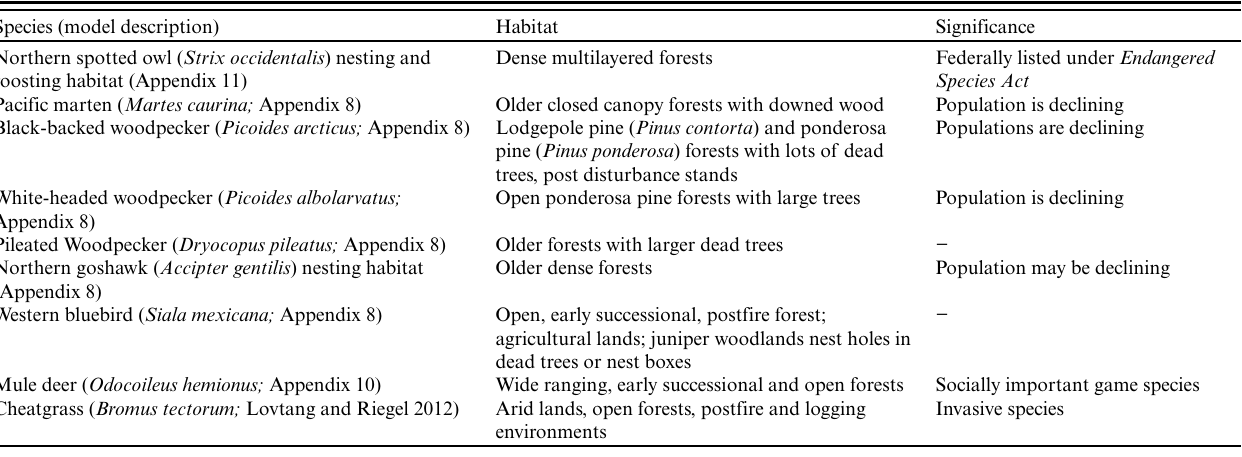
Table 2. Characteristics of habitat and conservation status of species of animals and plants used in the model. See Appendices 8, 10, and 11 for details. Expert opinion models were based on those developed for this region by Morzillo et al. (2014). Species (model